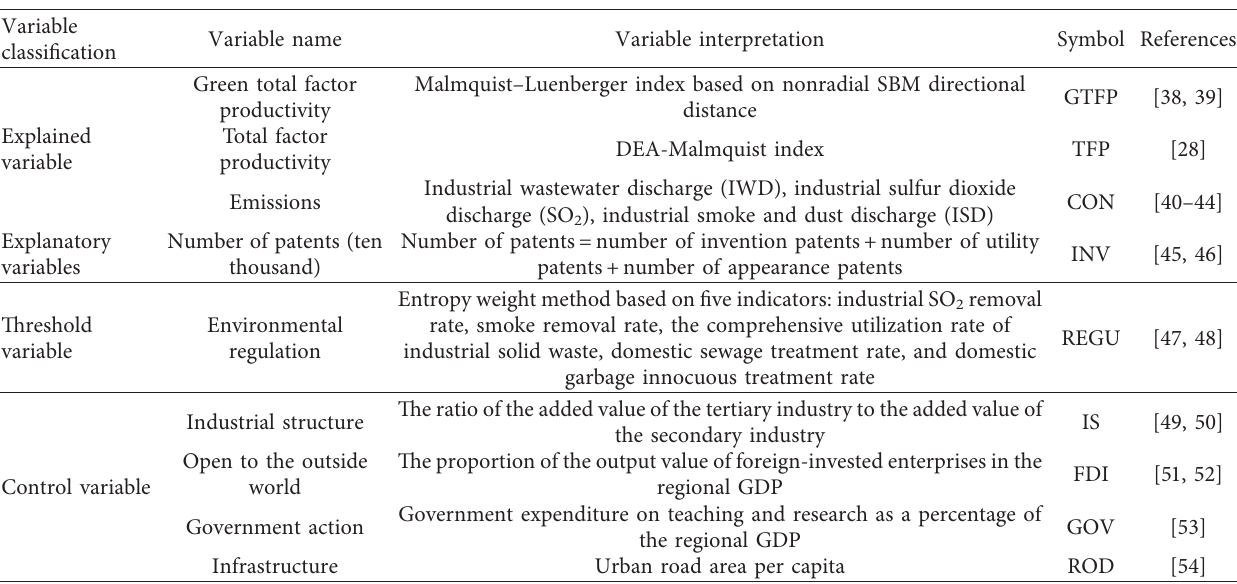
Table 2: Variable